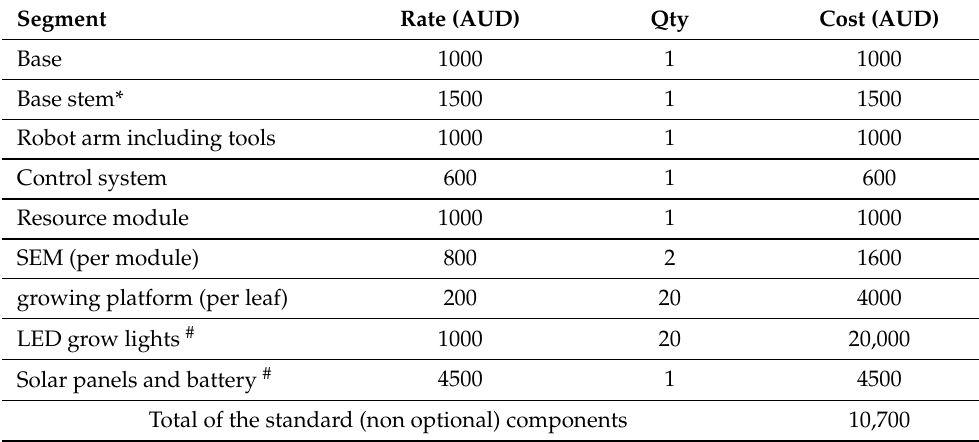
Table 3. Cost estimation for prototyping the self-assembling robotic